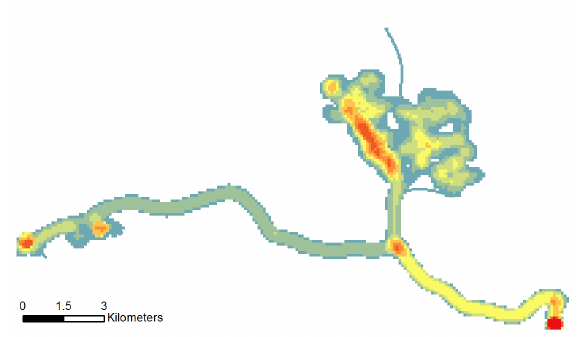
Figure 5: Trajectory generalisation - KDE for line segments de- rived from GPS trjectories. Kernel bandwidth 100m for the cell 50m. This example is derived from the anonymised GPS trace where all the significant locations were cloaked.